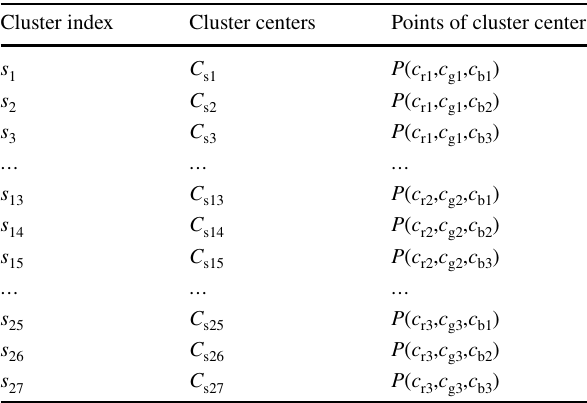
Table 4 Cluster centers and points corresponding to centers Cluster index